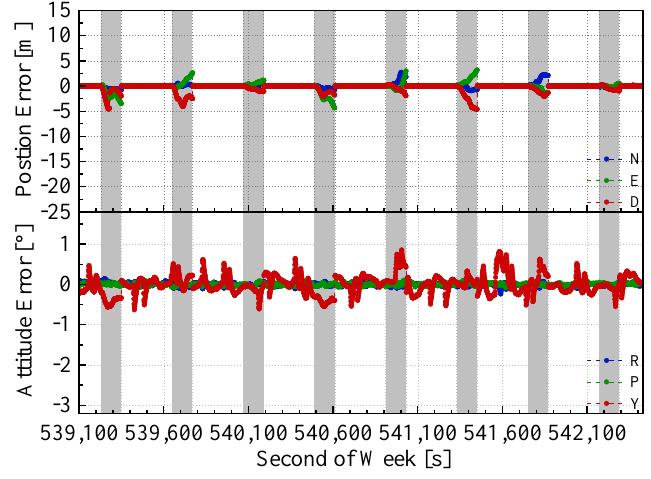
R P Y Figure 10. GNSS/IMU/ODO/LiDAR-SLAM navigation errors in test #2 (with 2 min GNSS outages).